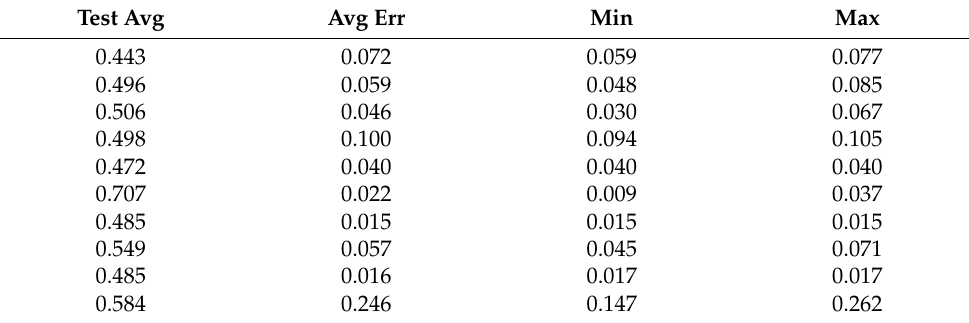
Table A193. Set 3, trials 21–30 data (average actual PR values).